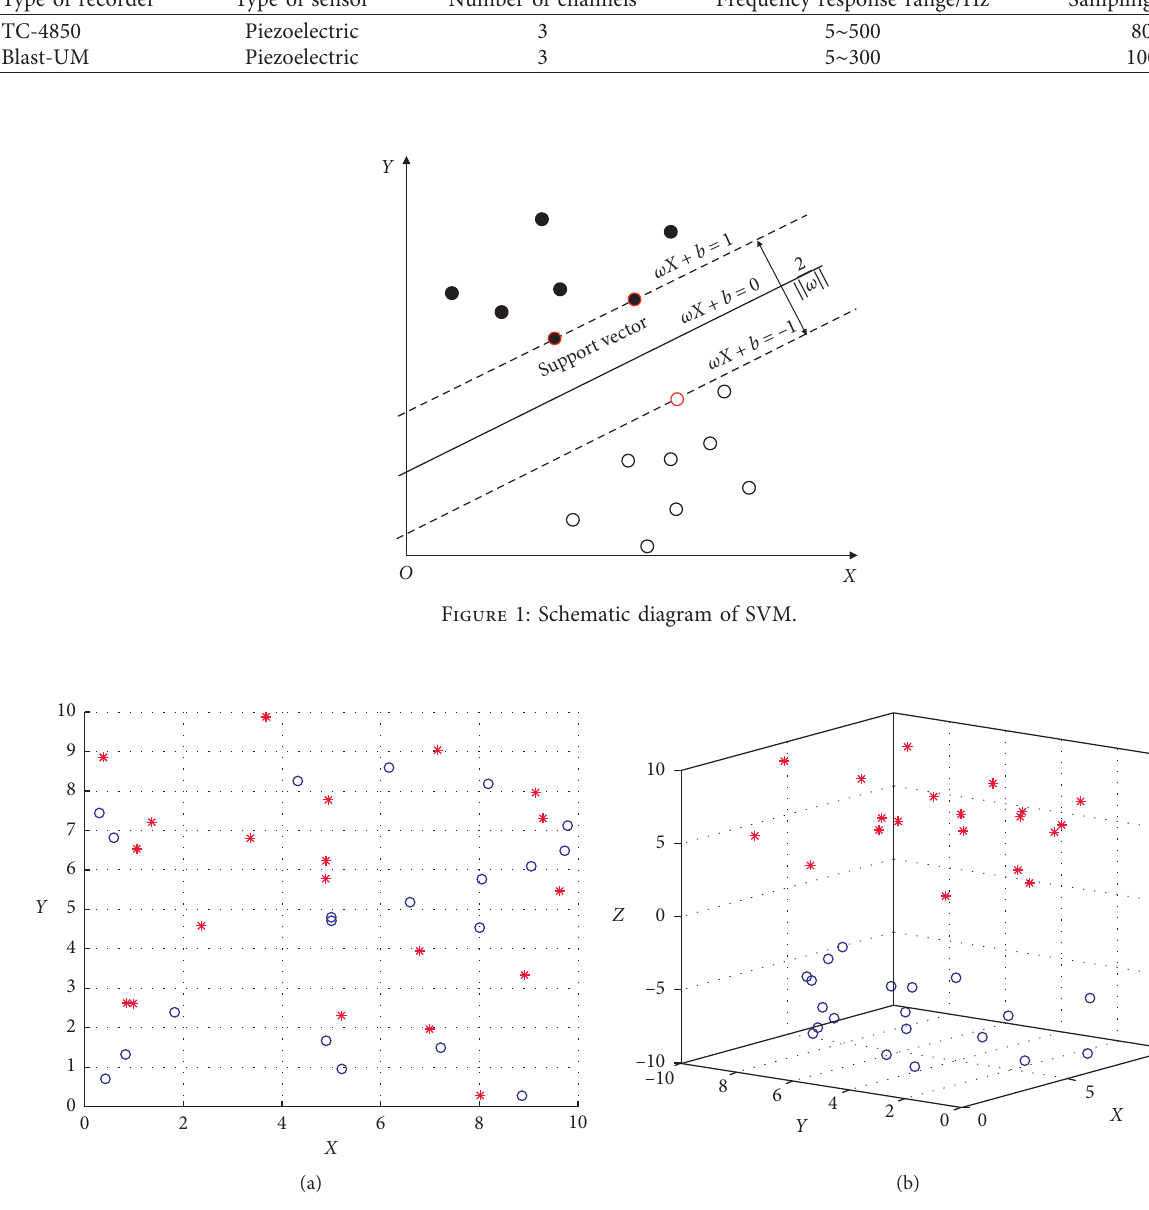
Figure 2: Nonlinear separable